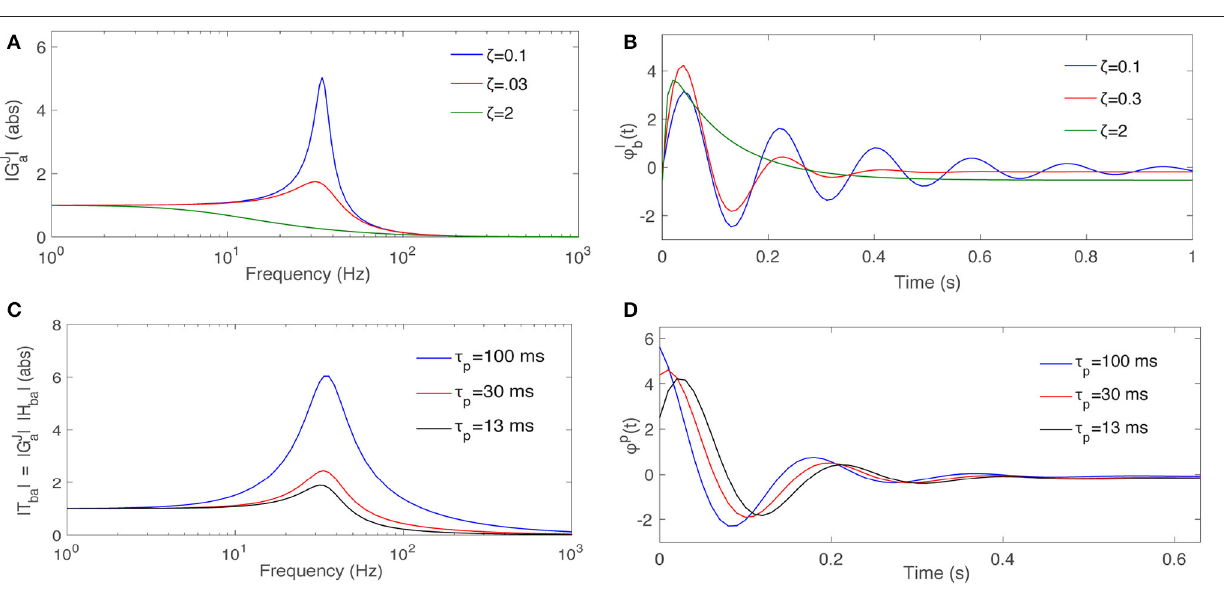
Frontiers in Human Neuroscience |